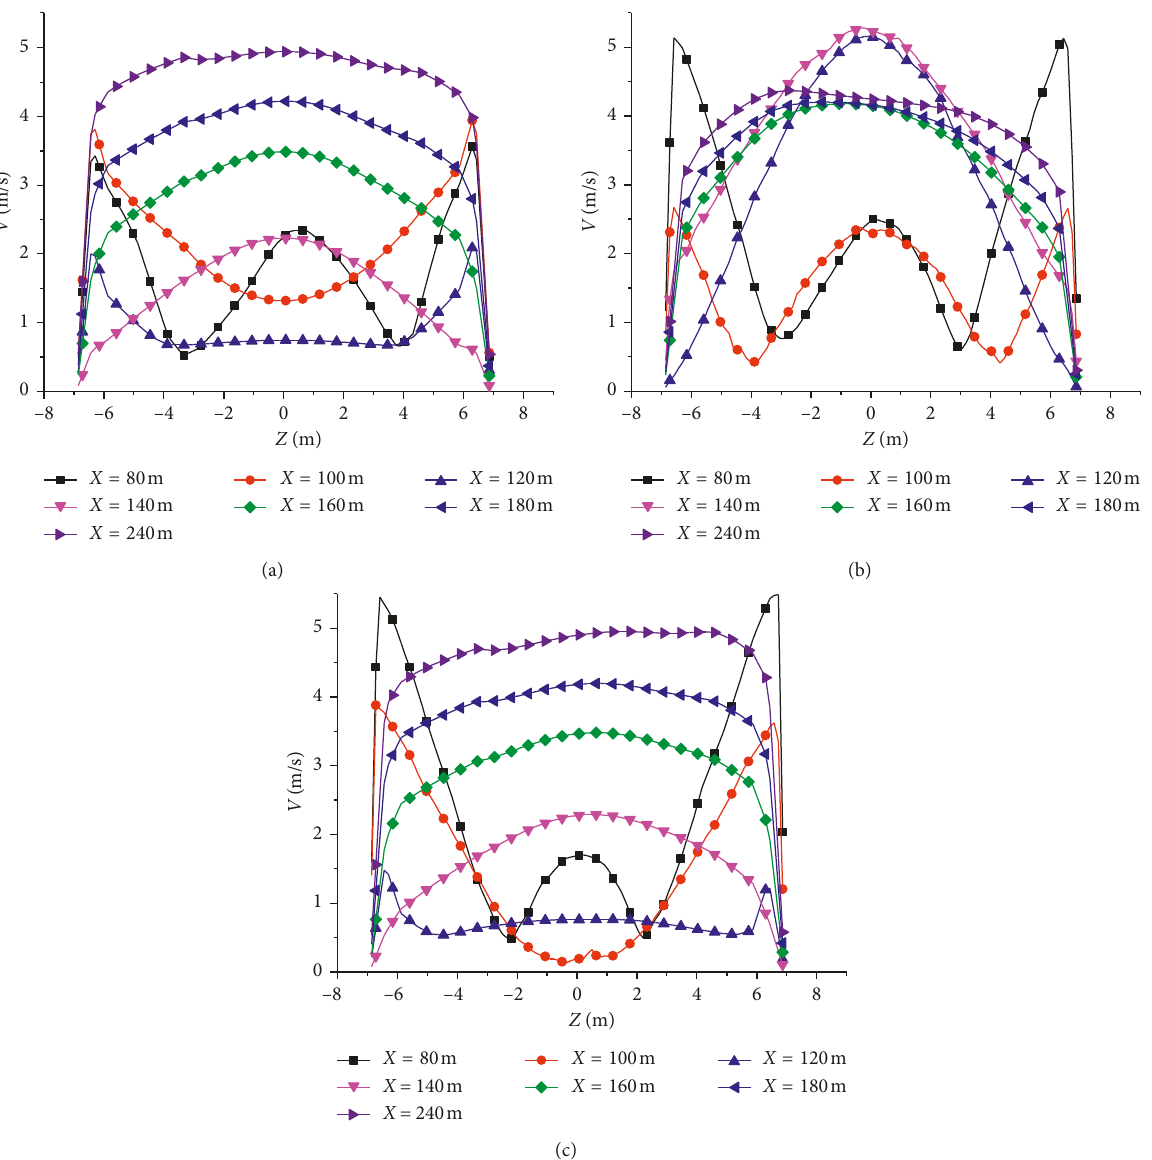
Figure 13: Velocity distribution at different positions at Z axial for u h t (cid:31)